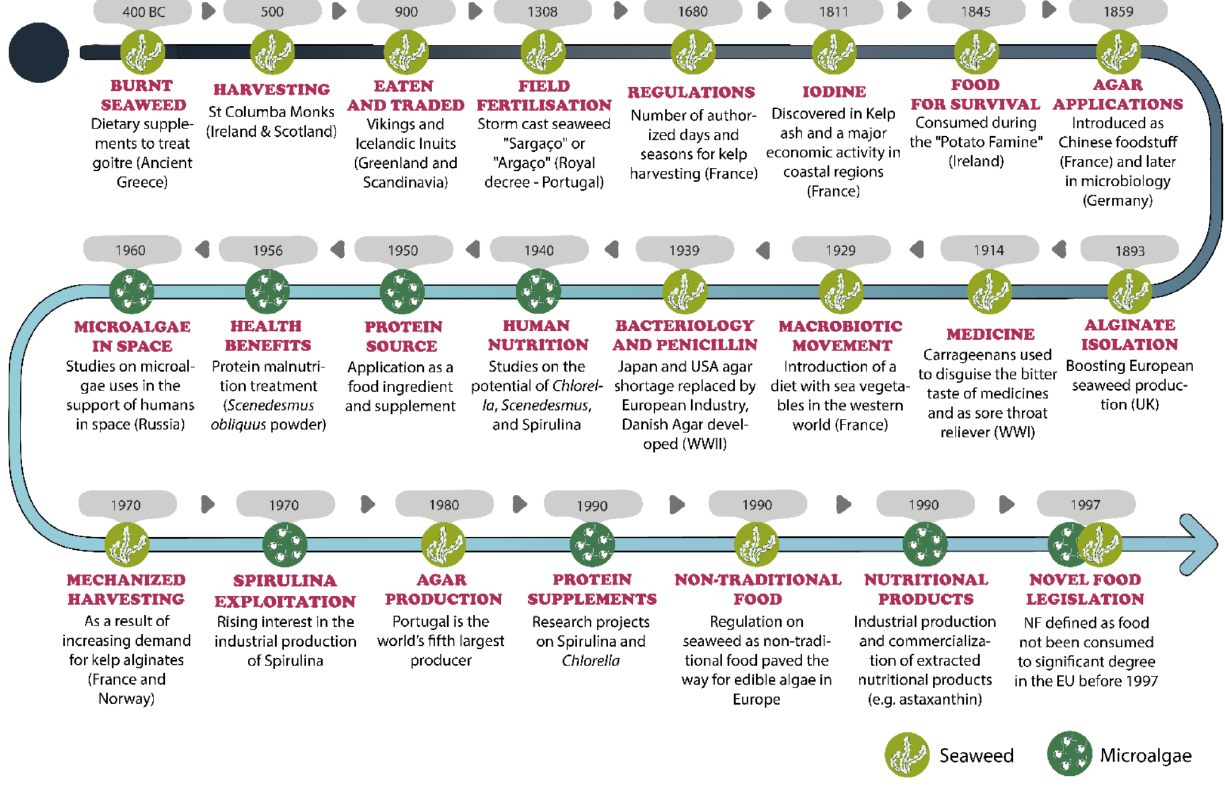
Figure 1. European historical marks on algae consumption as a food and food supplements (image not scaled)